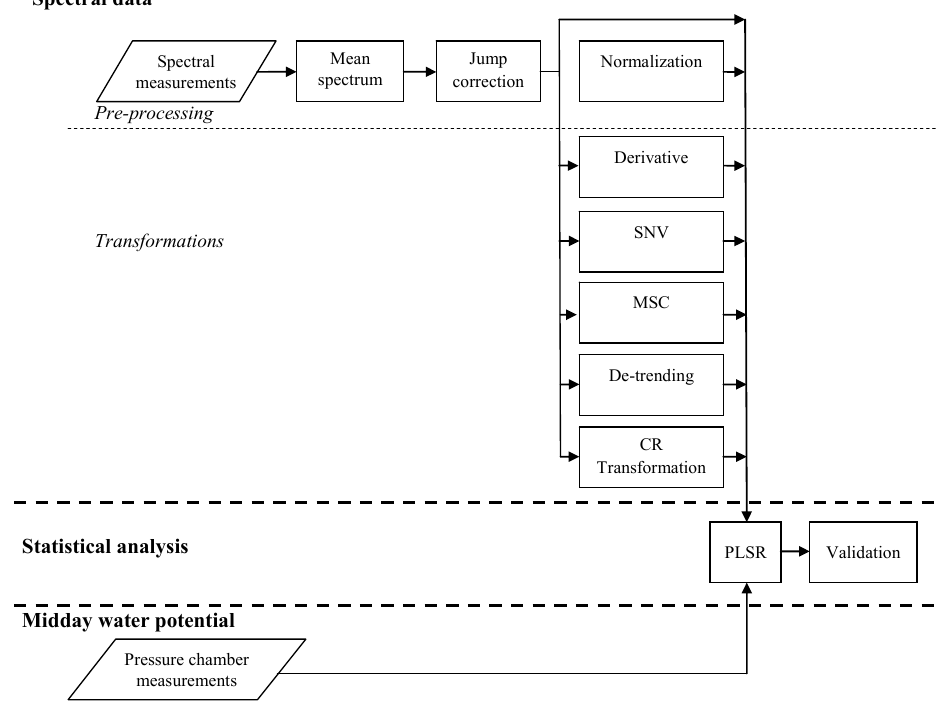
Figure 2. Flowchart depicting midday water potential estimation by spectroscopy. SNV: standard normal variate; MSC: multiplicative scatter correction; CR: Continuum Removal; PLSR: Partial Least Square Regression.